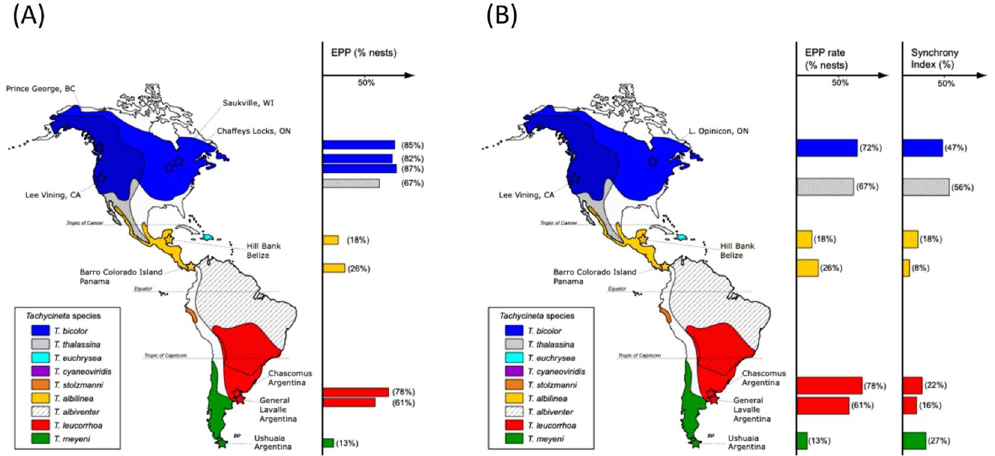
Figure 1. Map of the ranges of the nine species of Tachycineta swallows. ( A ) Bars on the right represent per cent of nests with extra-pair young for the colonies sampled, including the ones reported for the first time in this study and those taken from the literature. ( B ) Bars on the right represent per cent of nests with extra-pair young for the colonies sampled and the per cent of breeding synchrony in the colony for the years sampled (note that EPP rates for Tree swallows differ in this respect between the two maps, this is because the study used for the reported synchrony showed a somewhat lower EPP rate for other years studied). Bars are coded by species (see colour codes) and are located at the approximate latitudes of the populations sampled.